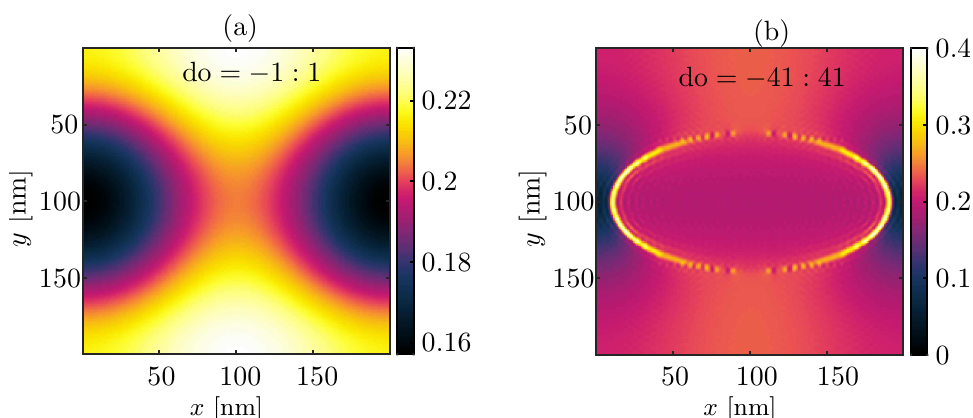
Figure A1. Electric energy density maps immediately behind the test mesoporous Si structure with ( a ) do = 1 : 1 and ( b ) do = 41 : 41. − −